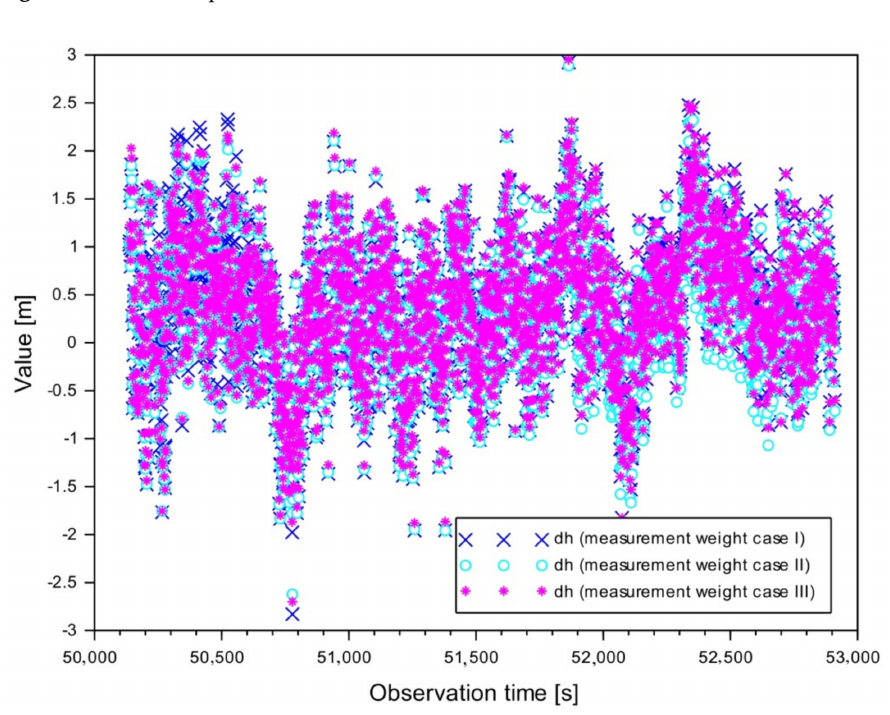
Figure 14. Results of position errors dL .